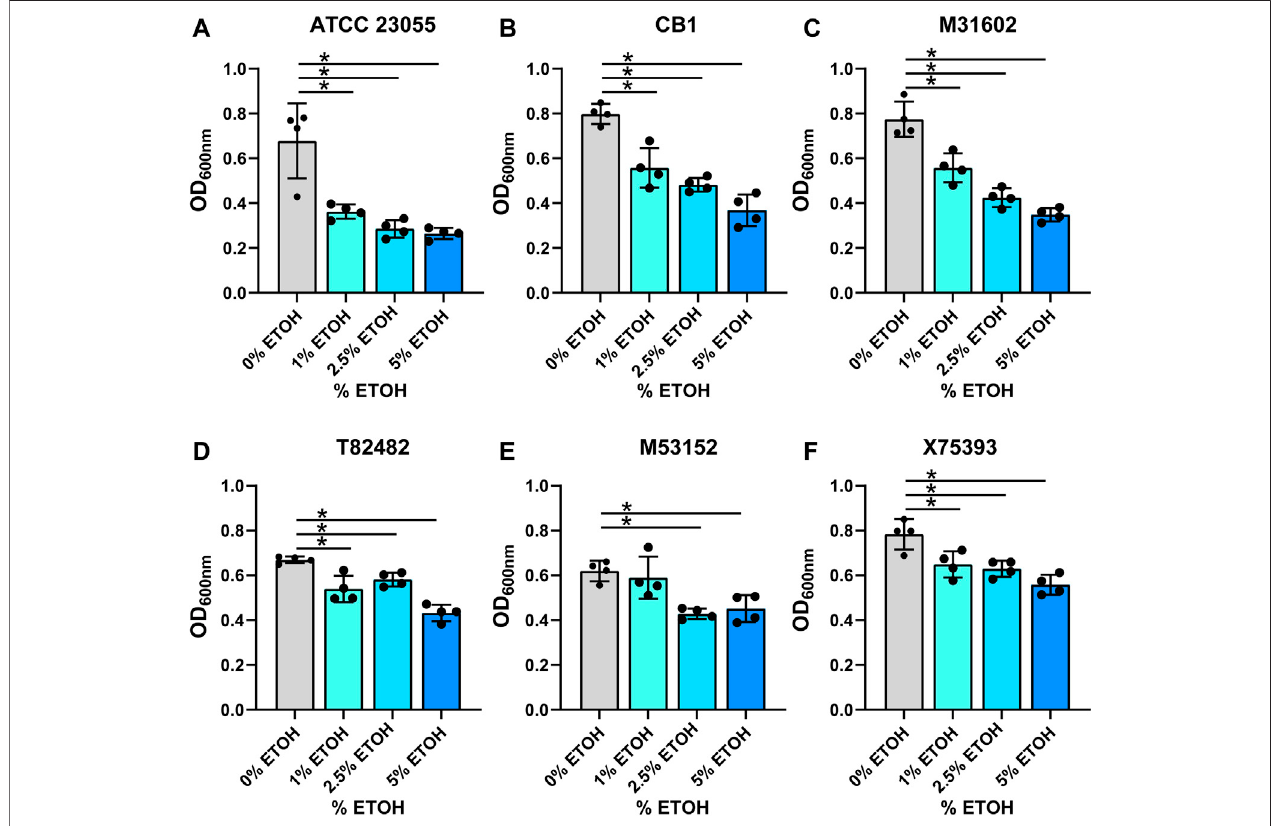
FIGURE3 | (A) calcoaceticus growth in percentagesof ethanol. Growth of A. calcoaceticus strains as measured byOD 600nm after 18 h ofincubation. Growth was examined in the following strains: (A) ATCC 23055, (B) CB1; clinical isolates: (C) M31602, (D) T82482, (E) M53152, and (F) X75,393). * p < 0.05, One Way ANOVA.